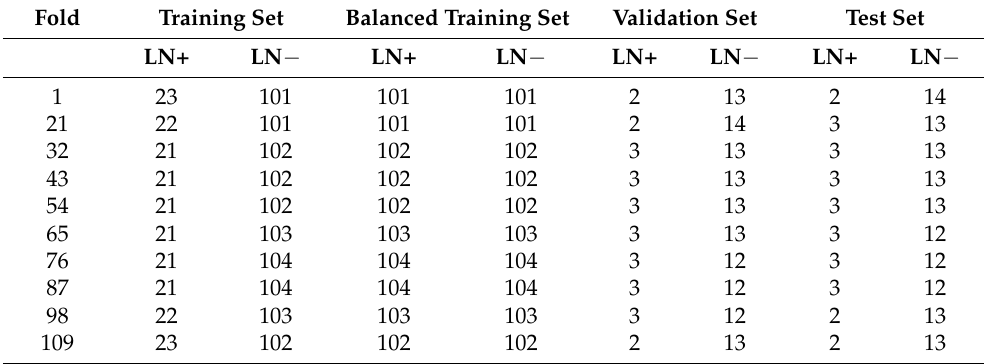
Table 3. Details about the number of samples in the training, validation, and test sets. Fold Training Set